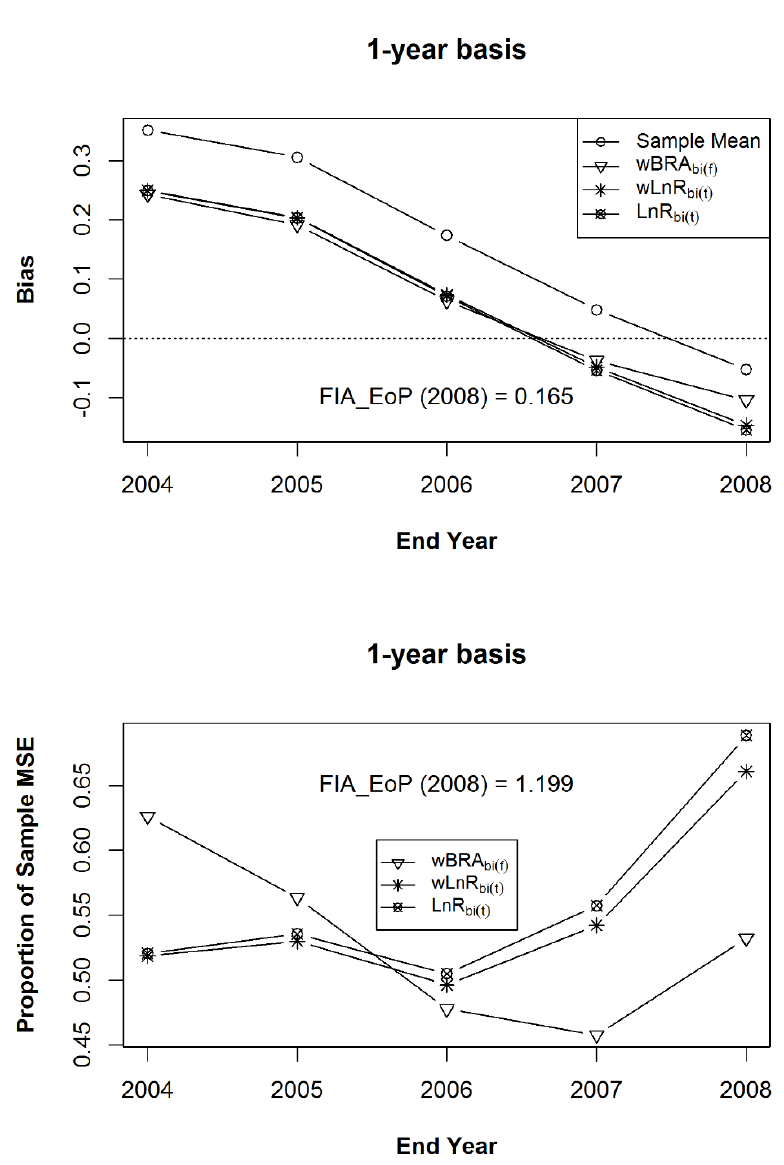
Figure 13. The mean bias ( a ) and the mean of Mean Squared Errors (( b ), expressed as a proportion of the MSE of the sample mean), relative to Estimand 3, for the bias-adjusted EoP estimators (for years 2004–2008), using the strong prior sample, after 100 iterations of samples of size 1000 within the 125 populations of a composite sample of sample observation lengths of five, six, seven, eight, and nine years, in equal proportions.